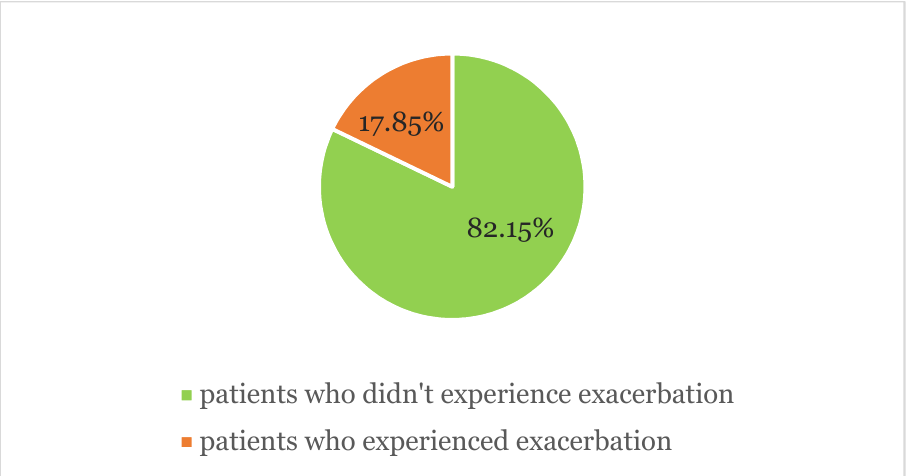
Figure 2. Exacerbation of CSU/CIU symptoms in the subgroup of patients who were taking omalizumab.